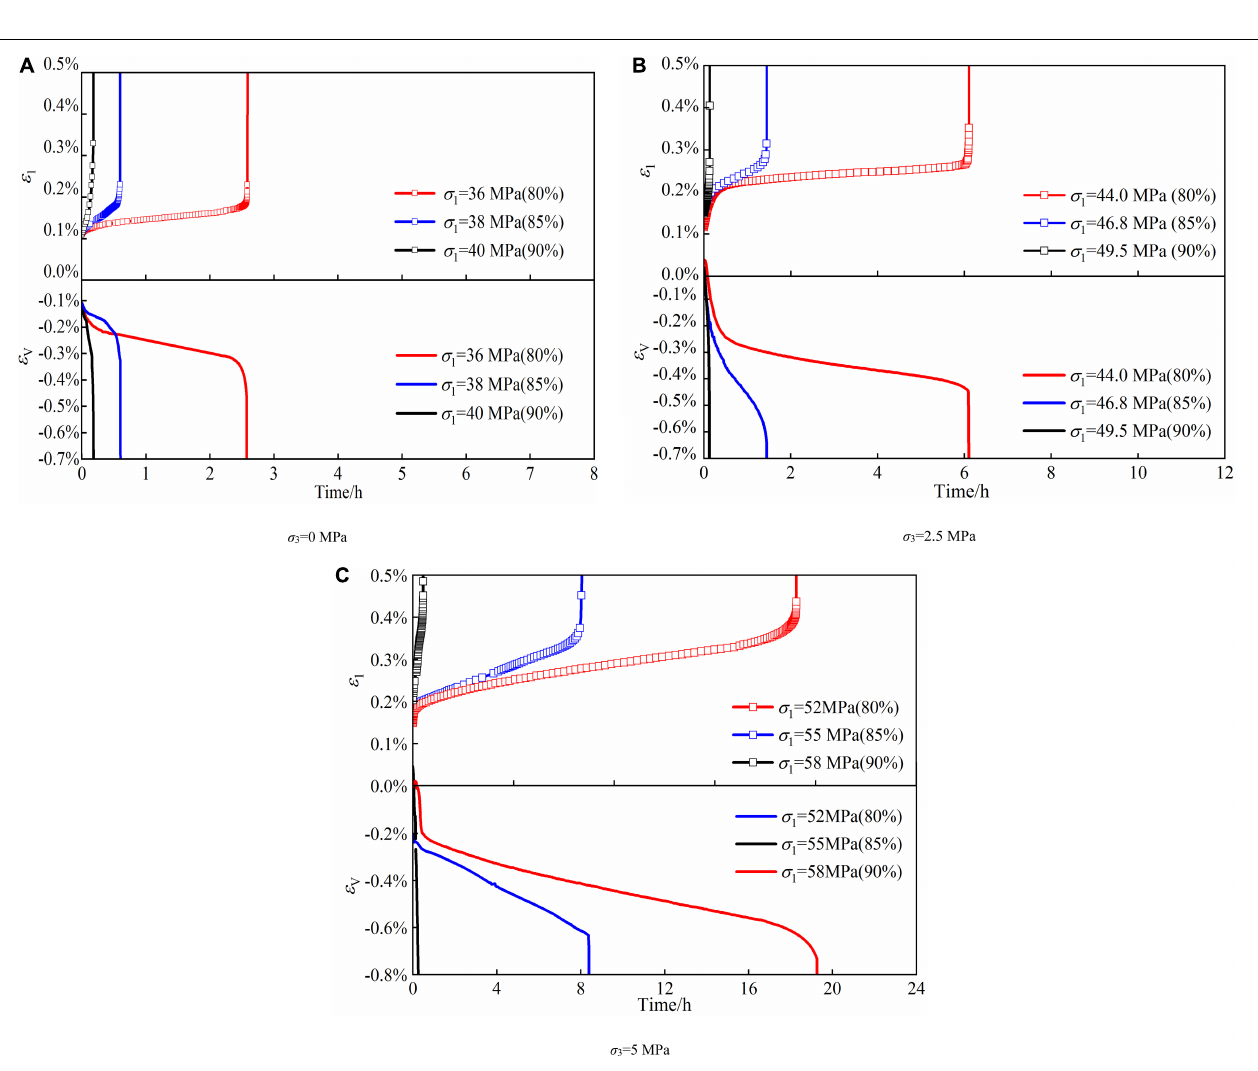
Frontiers in Earth Science |